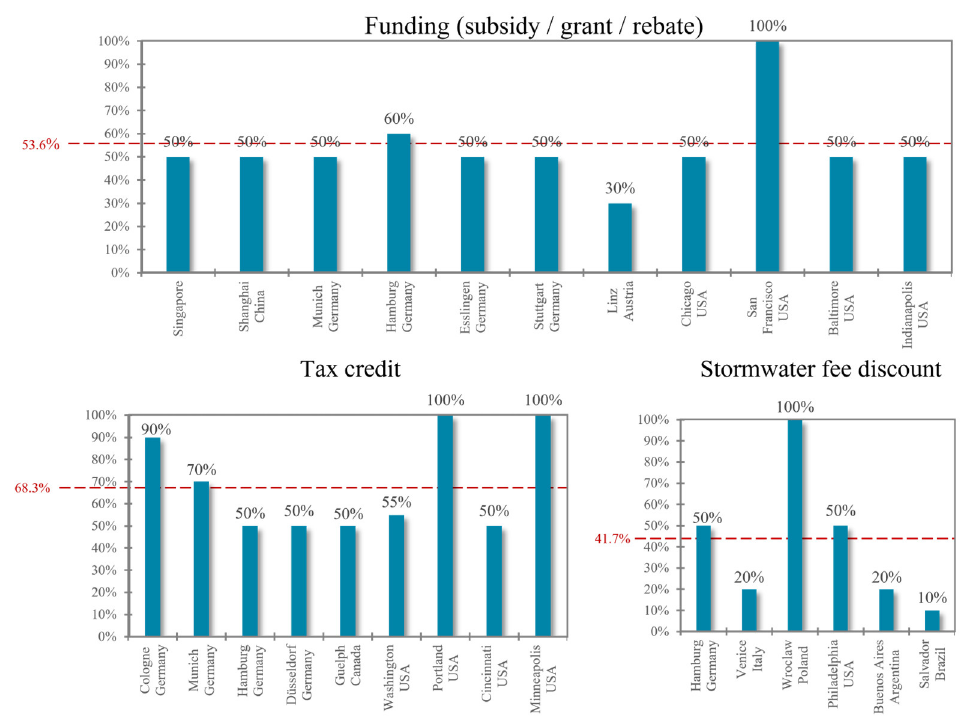
Figure 8. Comparison of financial incentives provided by different cities.